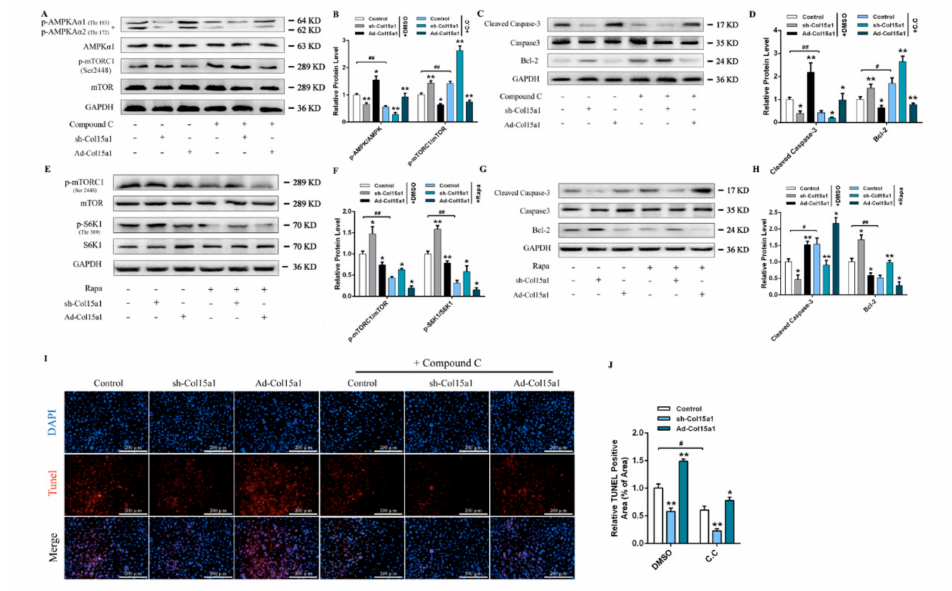
Figure 3. AMPK / mTORC1 signaling pathway was activated and act as a checkpoint during